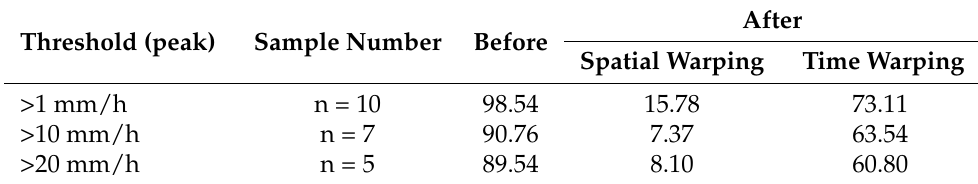
Table 2. Average position error (in km) before and after warping. The average is over all time steps at which the rainfall peak (in the target field v ) is above a certain threshold.